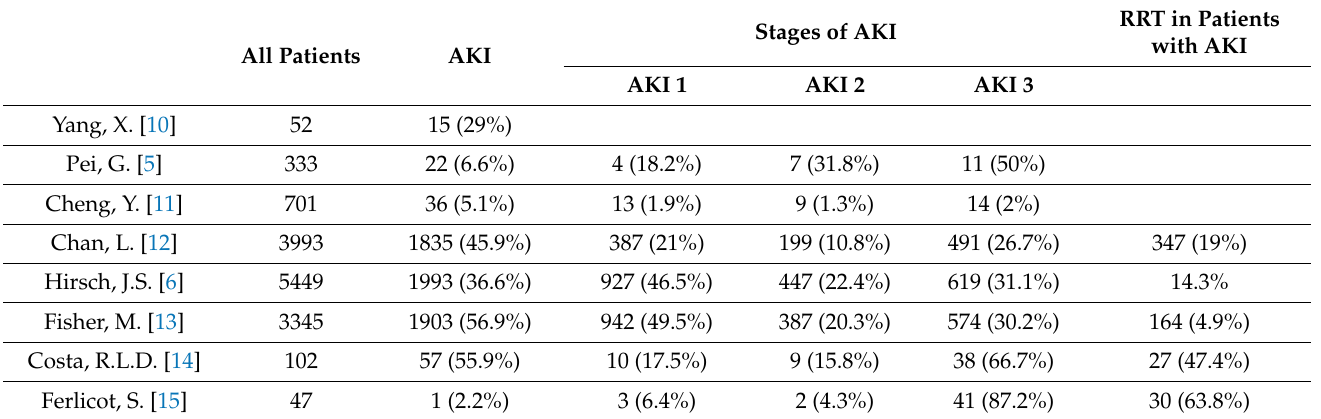
Table 1. Incidence of AKI in COVID-19